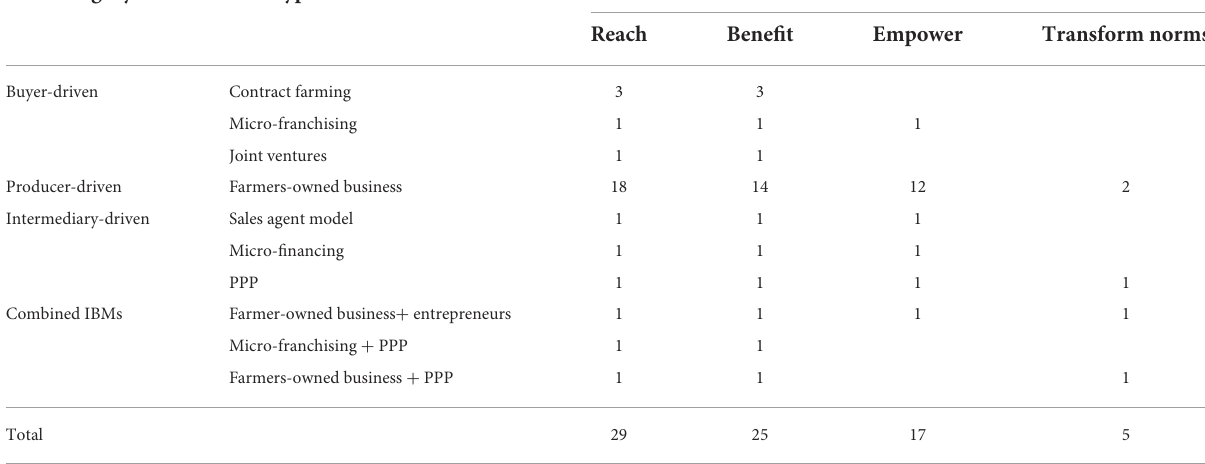
TABLE 4 Numbers of studies on inclusive business models by gender